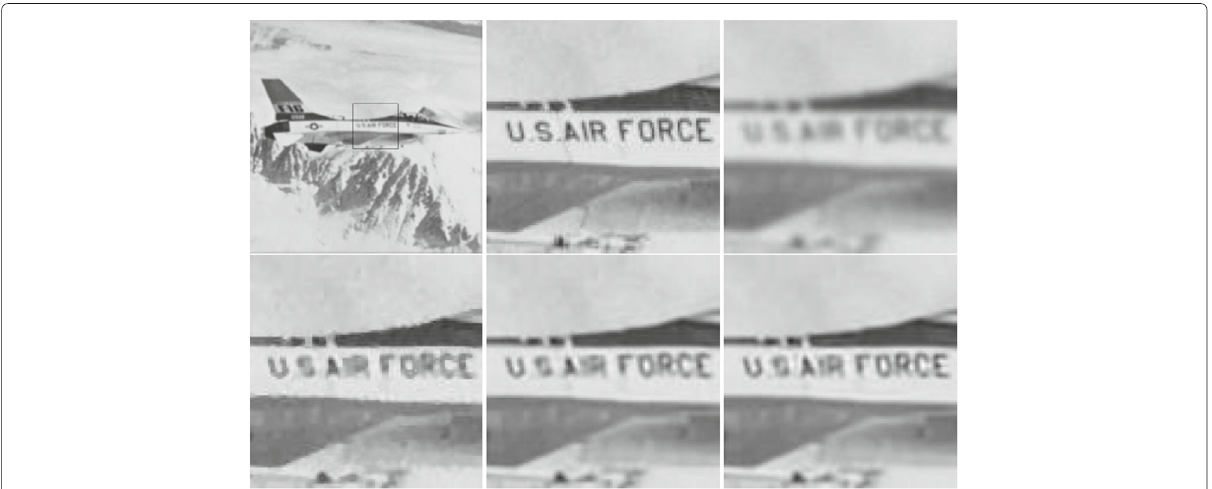
Fig. 3 Deblurring of Jetplane image, scenario 5. From left to right and from top to bottom are the following images: blurred and noisy , fragments of original , blurred, and noisy , results of Fnnmm, IDD-BM3D, and ours. In our method (fixed parameters), the two input parameters, (σ , s ) , are ( 7.5,50 ) for this scenario, ( 7.5,85 ) for scenario 1, ( 7.5,25 ) for scenario 2 , ( 7.5,550 ) for scenario 3, ( 7.5,10) for scenario 4, and ( 7.5,5 ) for scenario 6. In our method with automated parameter setting, σ thr = 3